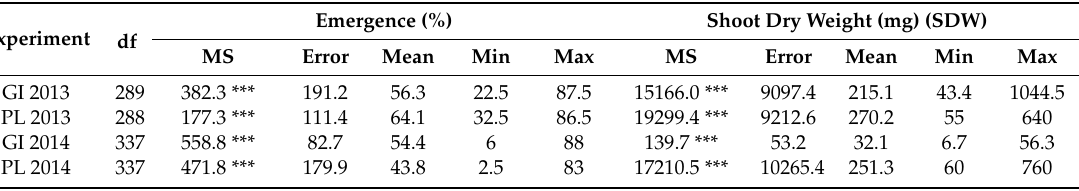
Table 4. Genotypic variances (mean squares, MS) and descriptive statistical traits for the di ff erent field experiments scoring chilling tolerance and juvenile development. Genotypic variances were